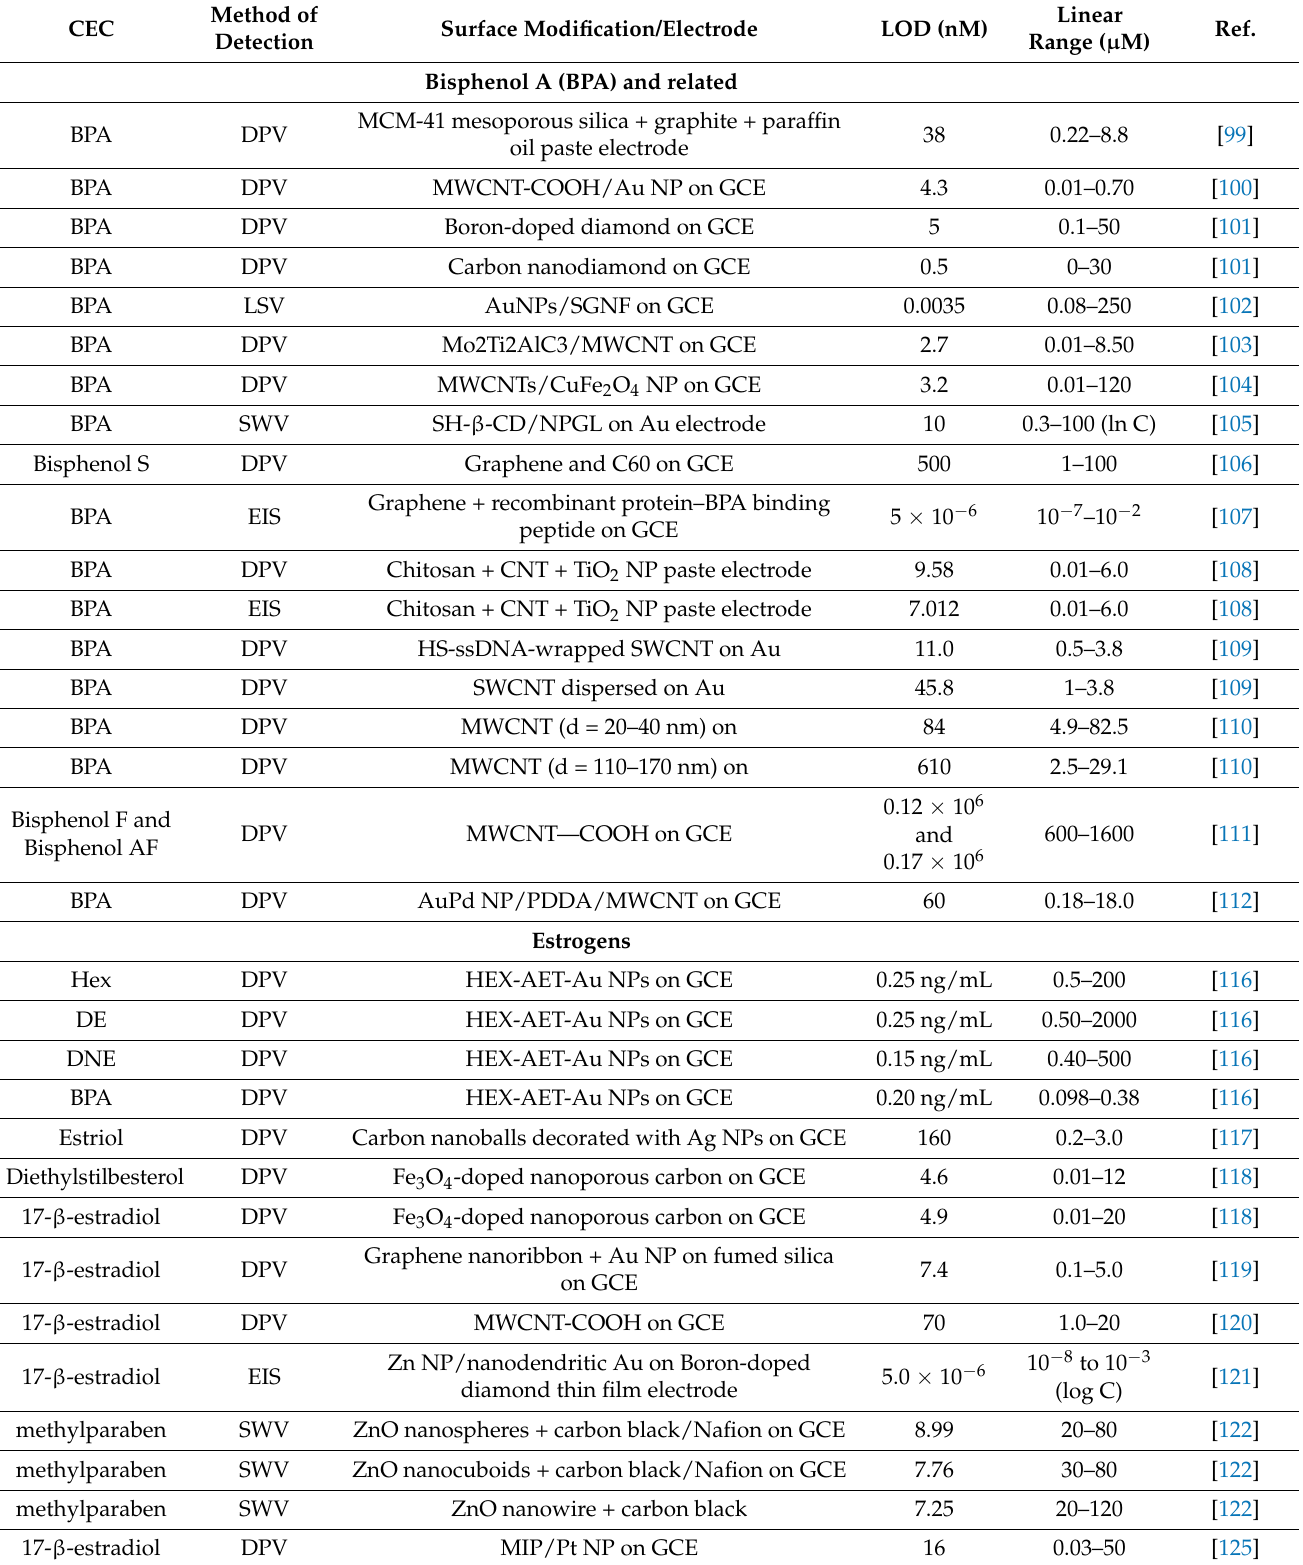
Table 2. Summary of different electrode modifications of electrodes, electrodes used, and electro- chemical sensing technique used in the detection of emerging